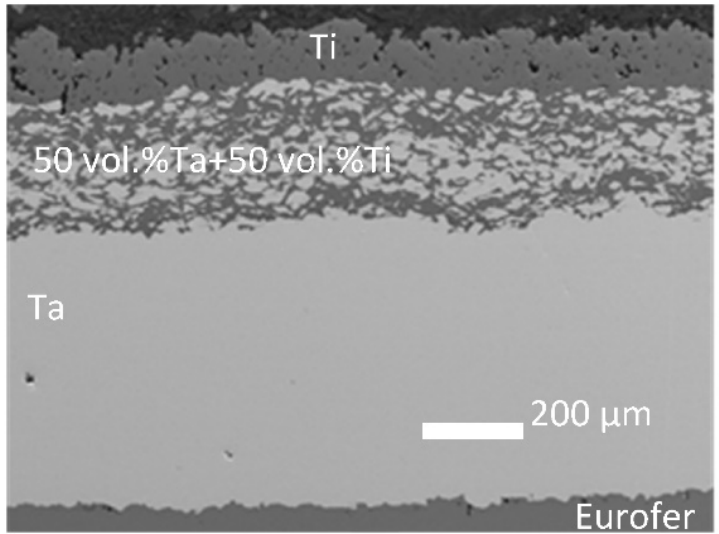
Figure 1. FGM coating (Ta, 50 vol.% Ta + 50 vol.% Ti, Ti) deposited on Eurofer97 substrate (SEM image with backscattered electron (BSE) contrast obtained with JEOL JSM 5800 LV).